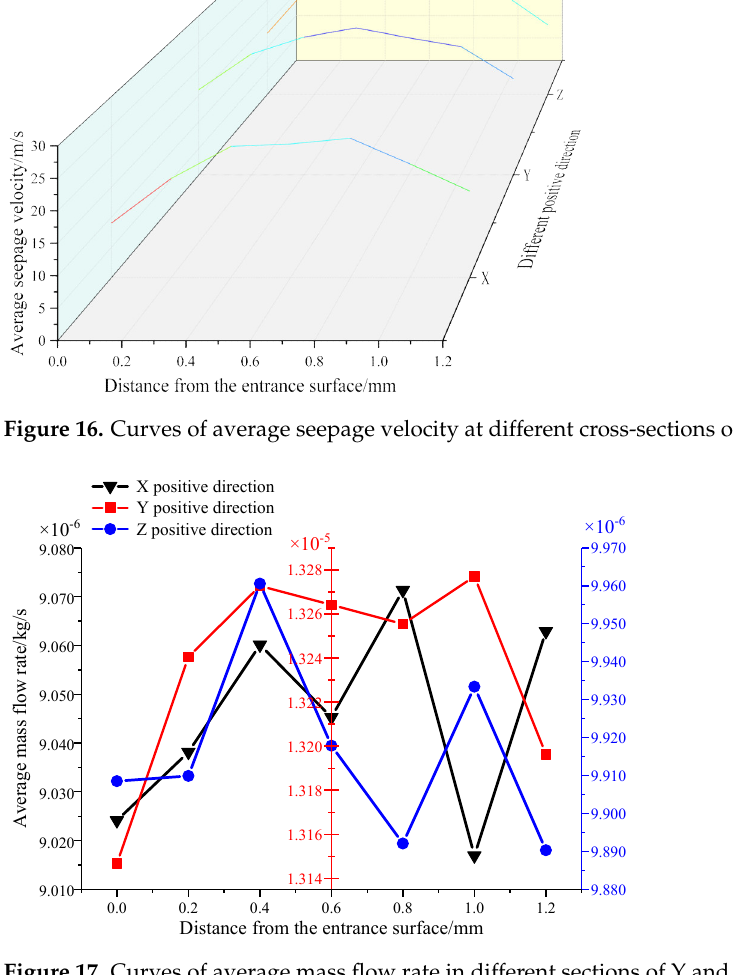
Figure 17. Curves of average mass flow rate in different sections of Y and Z seepage.